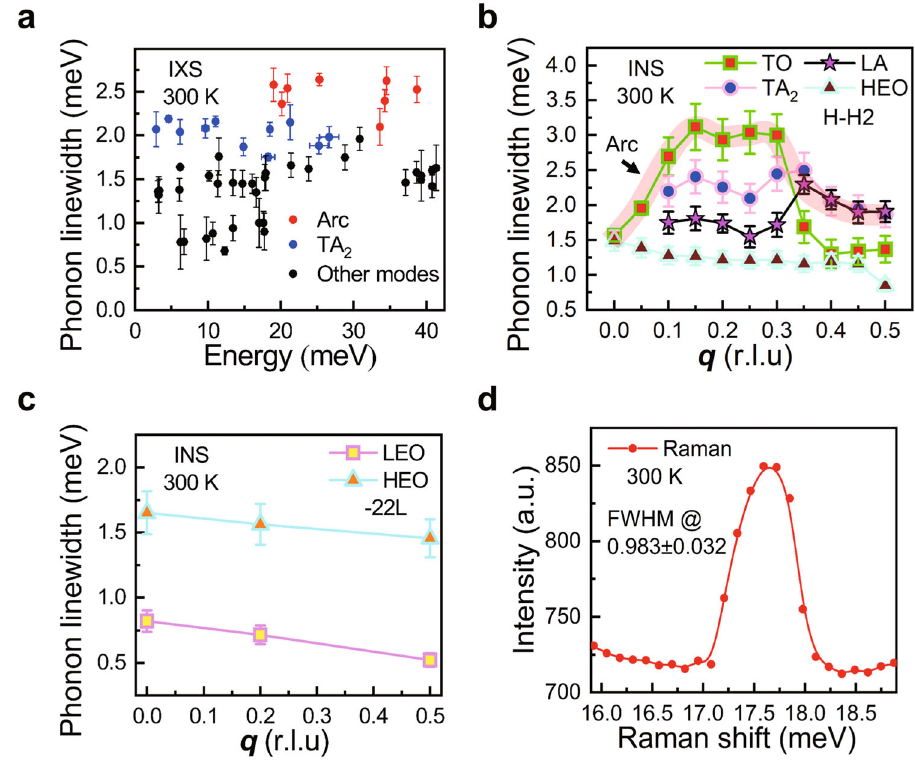
Fig. 4 Phonon linewidths of the low-energy modes in α -GaN. a Linewidths of phonon modes from the inelastic X-ray scattering (IXS) data at 300 K. b , c Phonon linewidths of the higher nested branch (Arc, composed of the low momentum q transverse optical, TO and the high momentum q longitudinal acoustic, LA modes) (light pink shadow), the second transverse acoustic (TA 2 ), and the high energy optical (HEO) modes along Γ ‒ M and phonon linewidths of the HEO and the low-energy optical (LEO) modes along Γ ‒ A from the inelastic neutron scattering (INS) data at 300 K, respectively. d Phonon mode and the linewidth (full width at half maximum, FWHM) of the Arc at Γ point from Raman data at 300 K. Raman spectroscopy only provides information on Raman-active modes at zone centers ( Γ point). The error bars are the uncertainties of a least-squares fi tting result from the damped- harmonic-oscillator model.